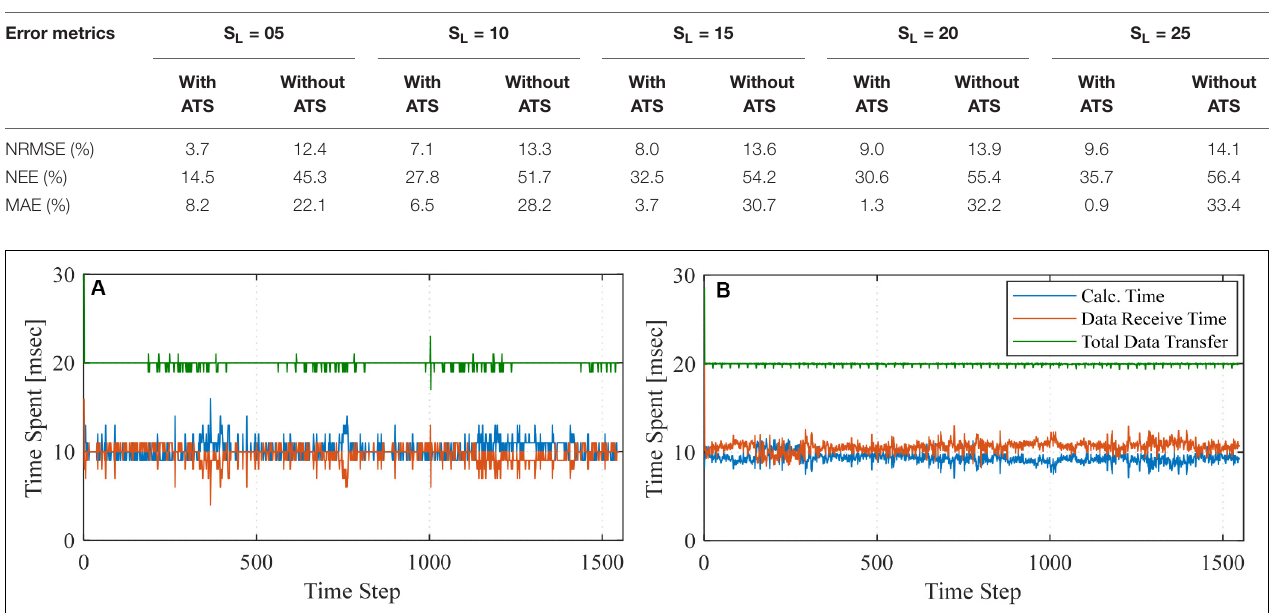
FIGURE 19 | Comparison of global force–displacement relationship for prototype CBF as obtained from pure OpenSees analytical solution and online RTHS with FE model (with ATS and S L = 15). TABLE 4 | Errors (%) in brace displacement response from online RTHS with FE model as compared to the pure analytical solution.